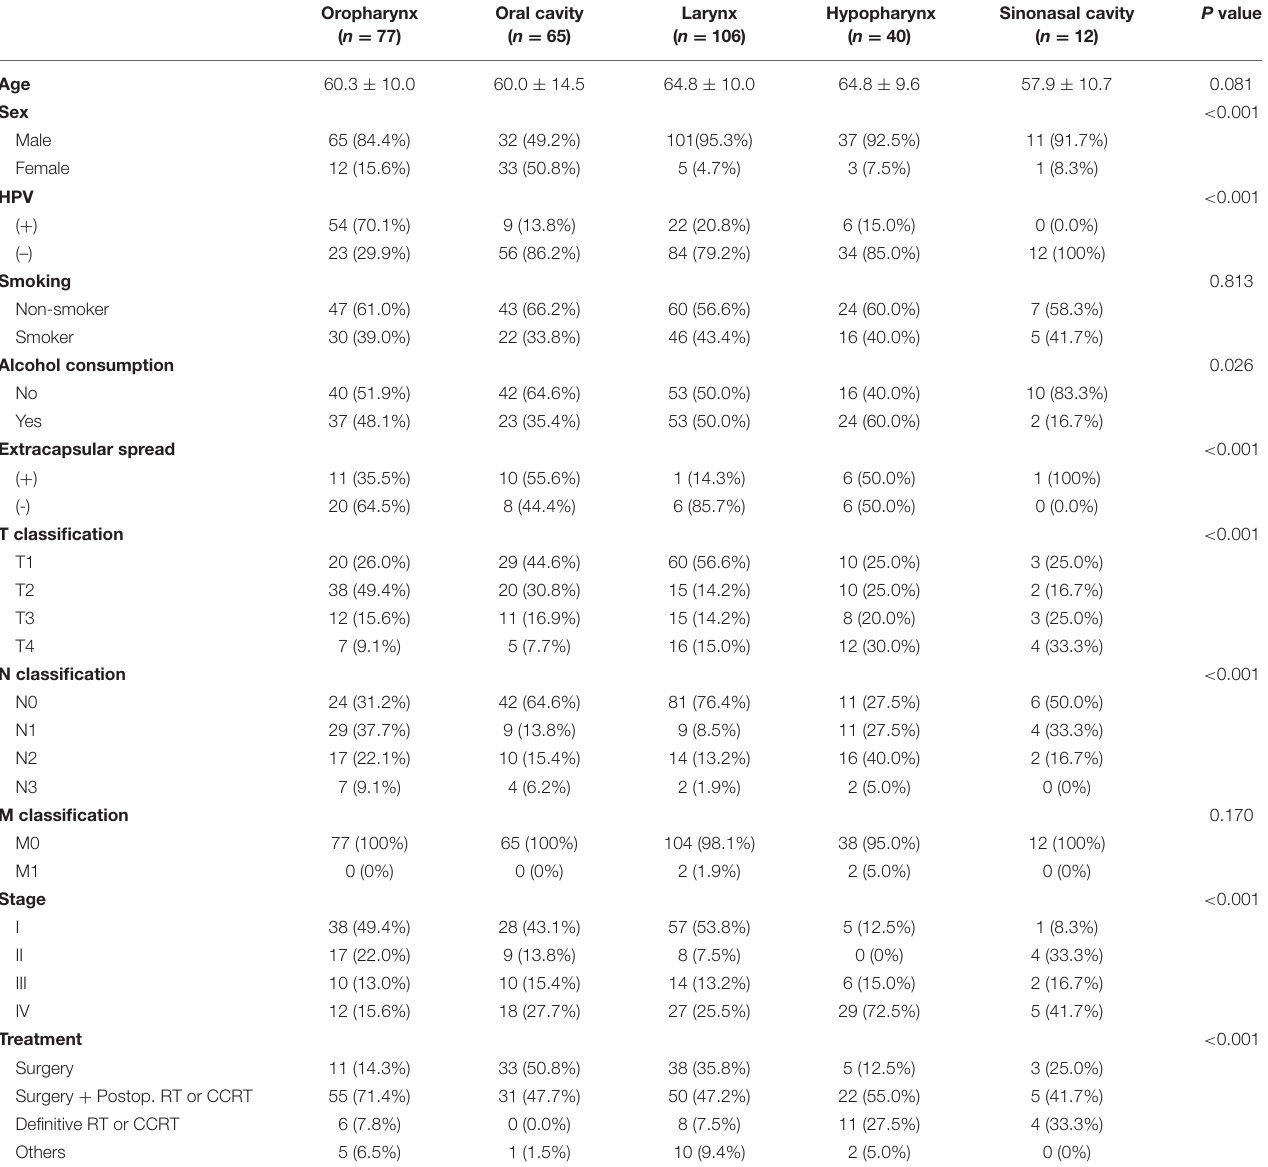
TABLE 1 | Demographics and characteristics of patients with head and neck squamous cell